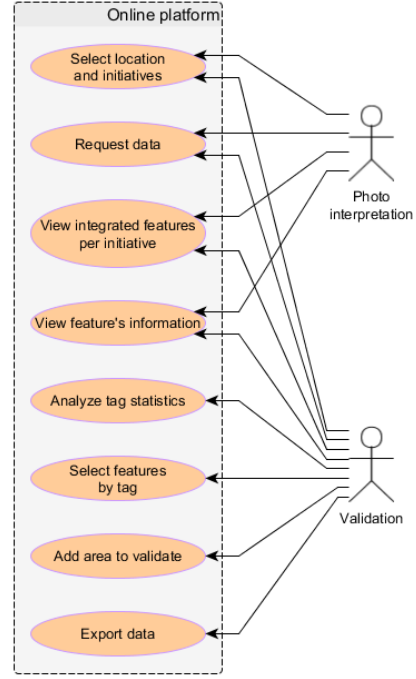
Figure 3. Integrated view of the use cases identified.